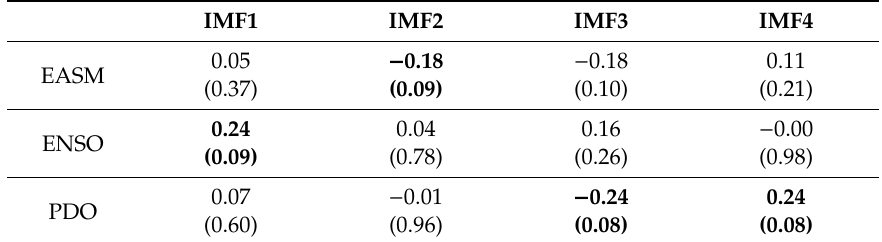
Table 4. The Pearson correlation coe ffi cients between plum rainfall and EASM, ENSO, and PDO (1960 to 2012). IMF1 IMF2 IMF3 IMF4 0.05 − 0.18 − 0.18 0.11 EASM (0.37) (0.10)